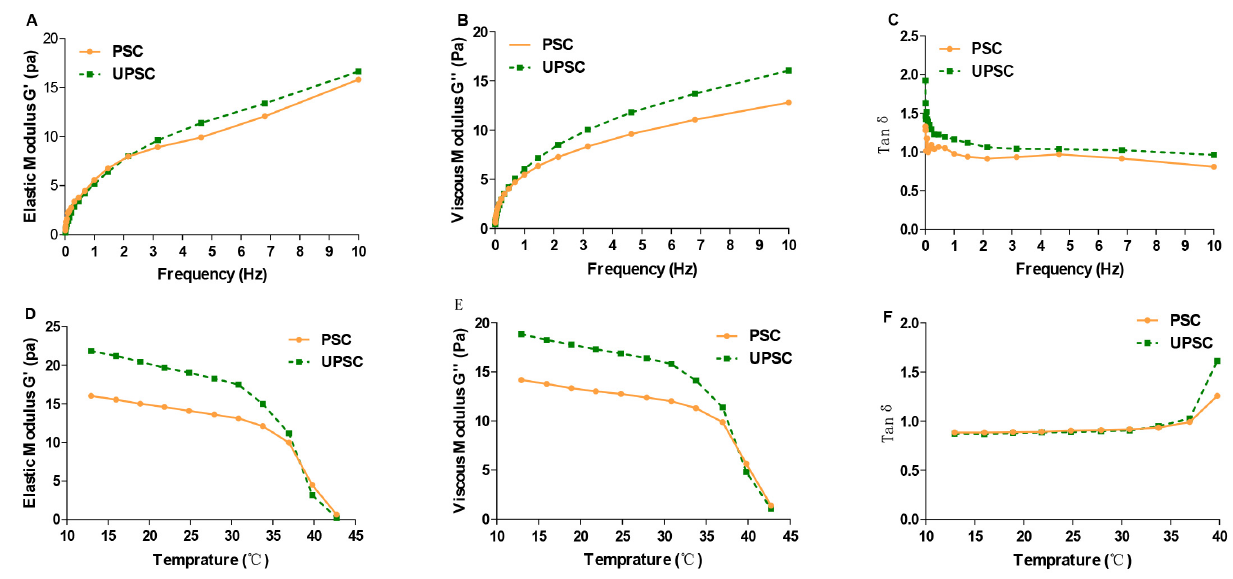
Figure 5. PSC and UPSC samples’ elasticity modulus G’ ( A , D ), viscous modulus G’’ ( B , E ), and loss tangent tan δ ( C , F ) in dynamic frequency sweep and temperature sweep tests (PSC, pepsin-solubilized collagen; UPSC, ultrasound-treated pepsin-solubilized collagen).